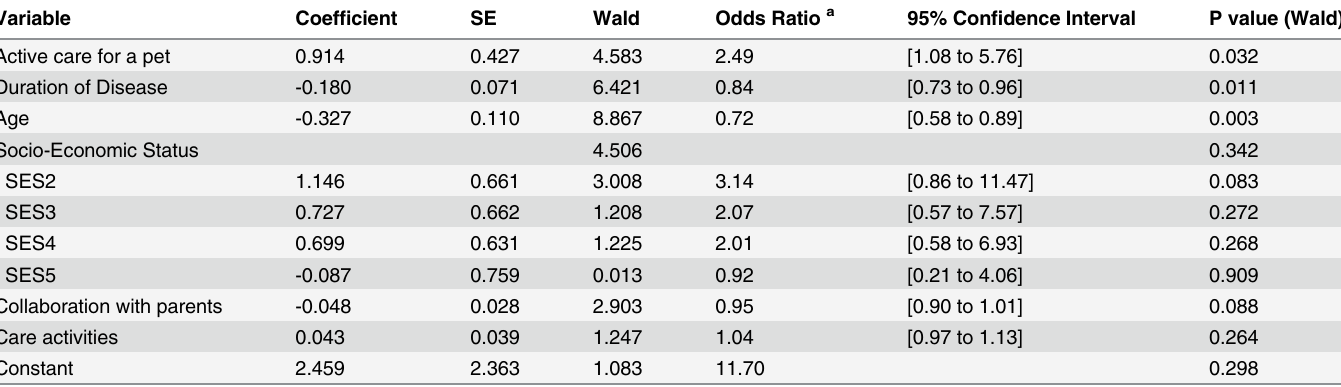
Table 3. Final multivariable logistic model: estimates of simultaneous effects of active care for a pet, duration of disease, age, socio-economic sta- tus, collaboration with parents and care activities on the glycemic target status of patients (n =